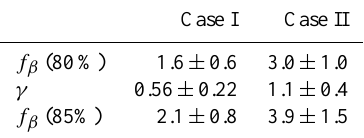
Table 2. Values of f β (80%), f β (85%) and γ for the two cases of hygroscopic growth corresponding to the 22 July of 2011 and 2013, respectively. The uncertainties in f β (RH) are obtained by er- ror propagation applied to Eq. (1). Only the uncertainty introduced by the aerosol particle backscatter coefficient is considered.